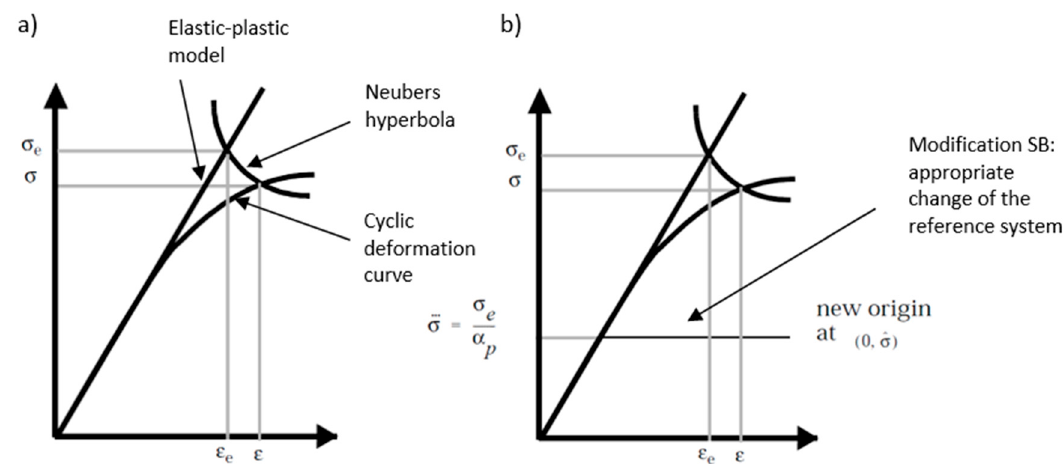
Figure 1. Calculation algorithm for determining fatigue life using the spectral method and stress correction due to elastoplastic deformation.